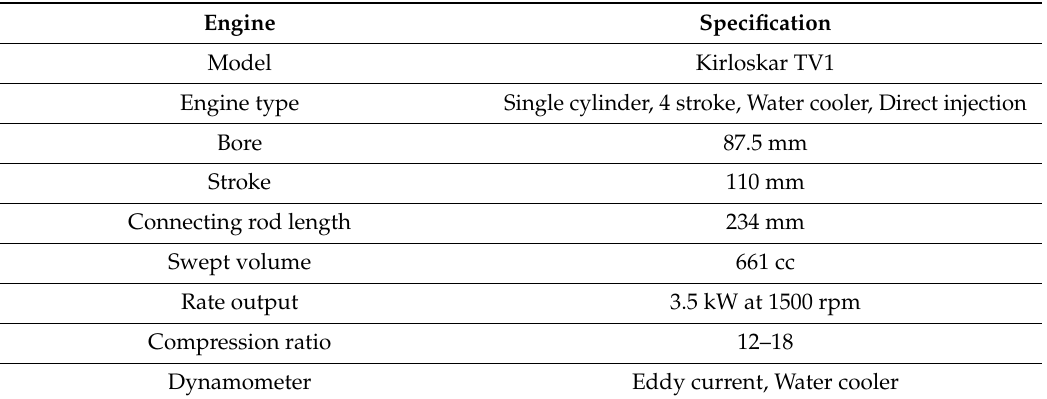
Figure 2. A schematic diagram of the experimental installation. Table 1. Test engine